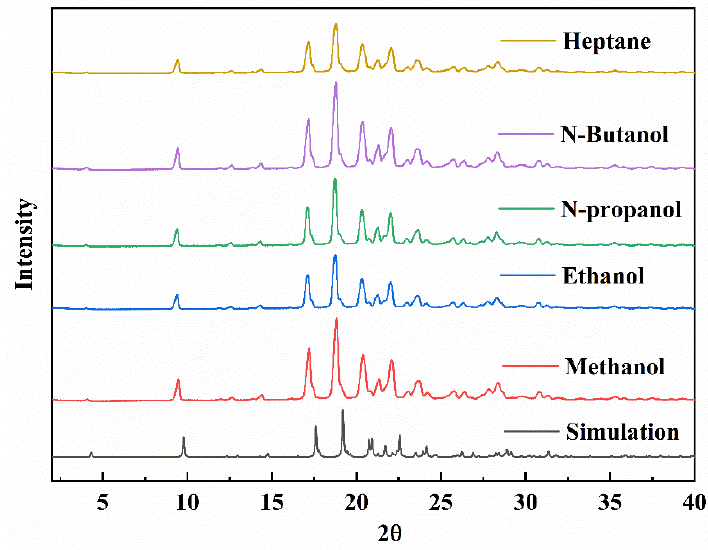
Figure 4. XRD patterns of the pyriproxyfen crystals obtained from different solvents and simulated by single crystal structure (CCDC number: 1412612).